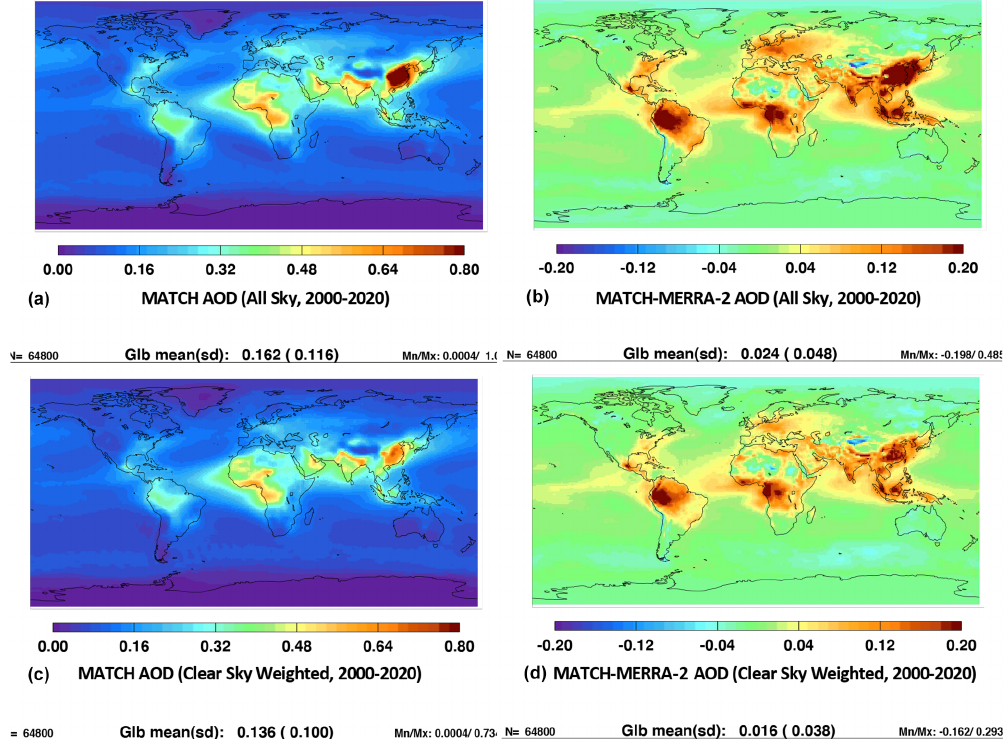
Figure 5. (a, c) Climatological mean AOD from MATCH and (b, d) the difference between MATCH and MERRA-2 (MATCH − MERRA- 2). Panels (a) and (b) show the all-sky results (AOD all ), and panels (c) and (d) show maps of the clear-sky-area-weighted average of MODIS AOD (AOD clr ). Clear-sky-weighted monthly mean AOD is derived by averaging the daily mean AOD weighted by the daily 1 ◦ × 1 ◦ MODIS gridded mean clear fraction, where the clear fraction is derived from the MODIS-based cloud fraction on Terra and Aqua.